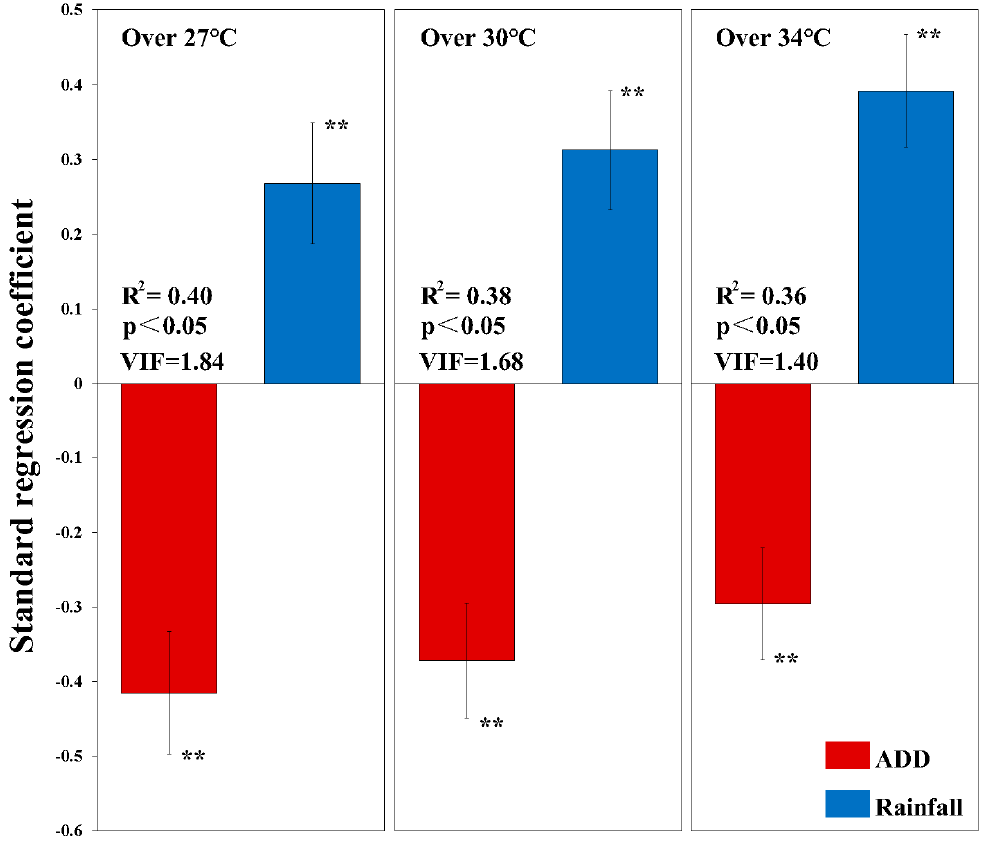
Figure 3. Estimated coefficients for ADD and rainfall in a standard regression to quantify the impacts of different heat stresses (over 27 °C, 30 °C, and 34 °C) on wheat yield. Error bars indicate 5–95% confidence interval and stars indicate statistical significance (**: p < 0.05).